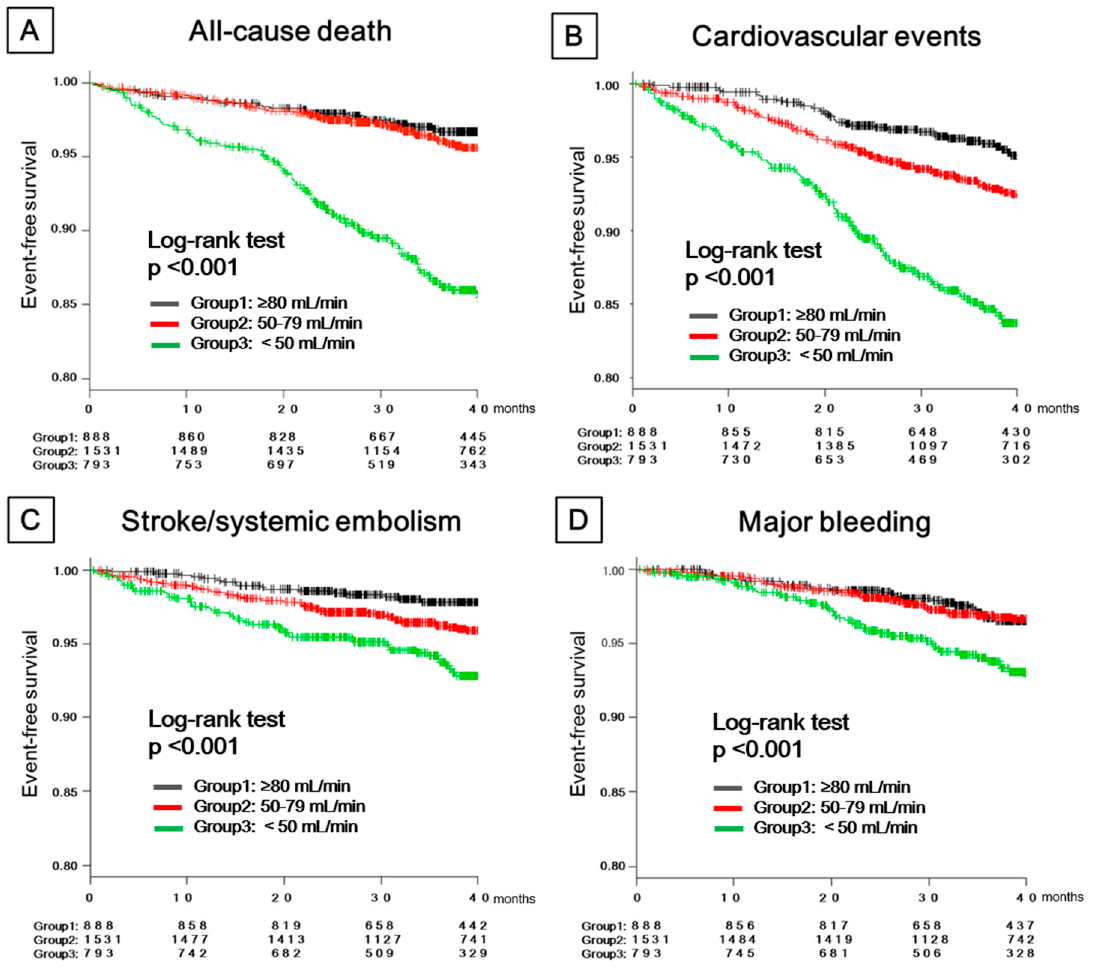
Figure 1. Kaplan–Meier curves for all-cause death, cardiovascular events, strokes/systemic embolisms, and major bleeding in patients classified by their renal function: ( A ) Kaplan–Meier curves of all-cause death, ( B ) Kaplan–Meier curves of cardiovascular events, ( C ) Kaplan–Meier curves of stroke/systemic embolism, and ( D ) Kaplan–Meier curves of major bleeding.